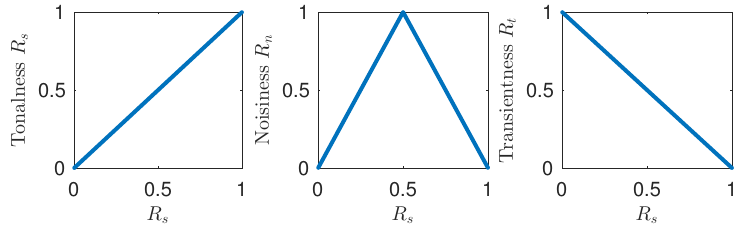
Figure 3. The relations between the three fuzzy